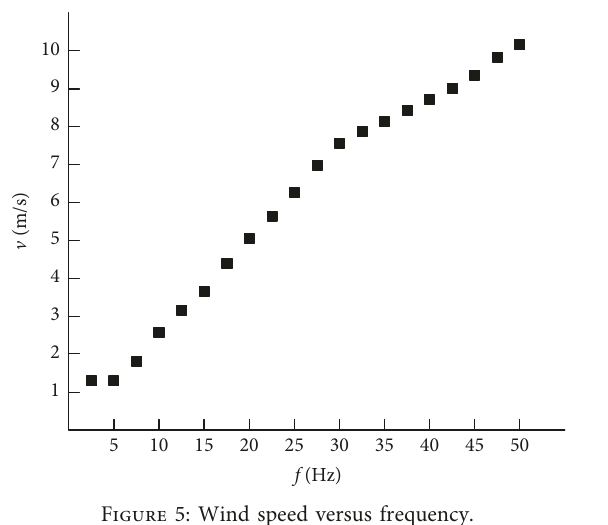
Figure 5: Wind speed versus frequency.